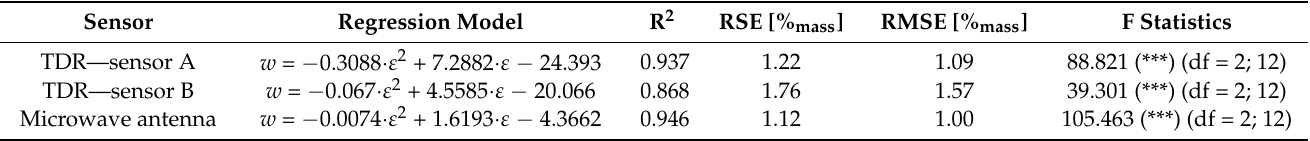
Table 2. Calibration models for TDR A and B sensors and microwave